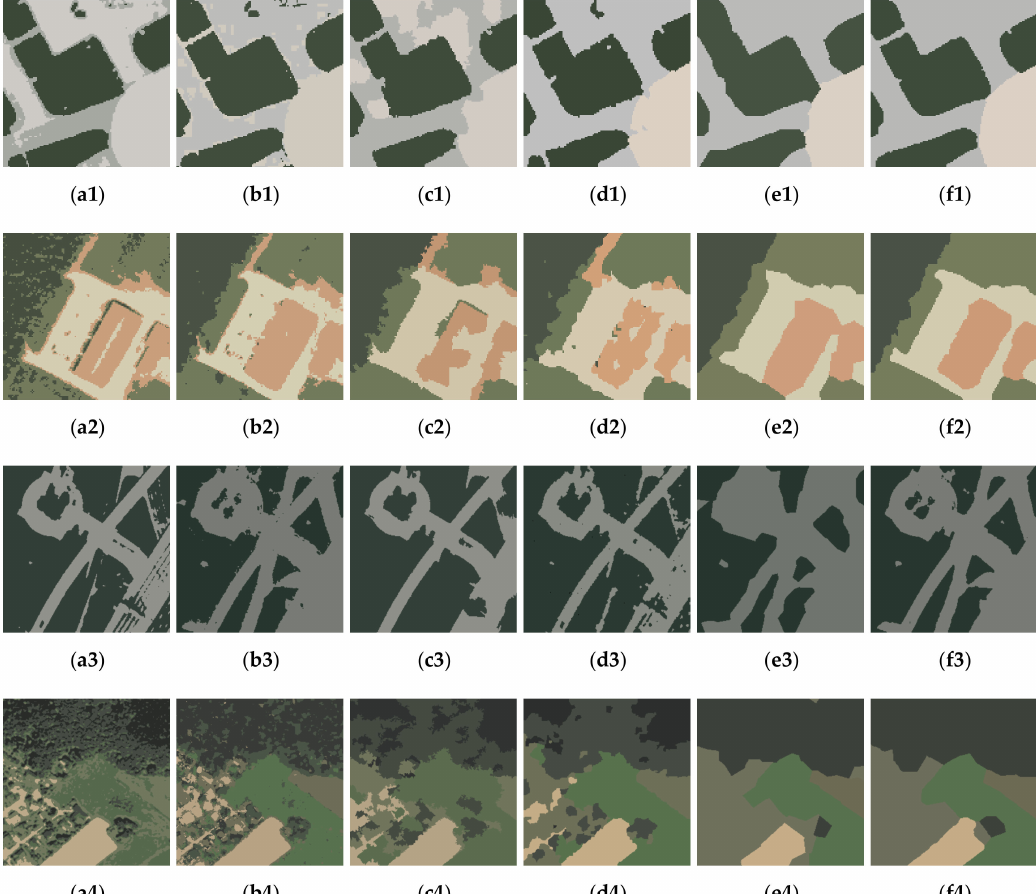
Figure 10. Segmentationresultsofmultispectralremotesensingimages.( a1 – a4 )FCM_S;( b1 – b4